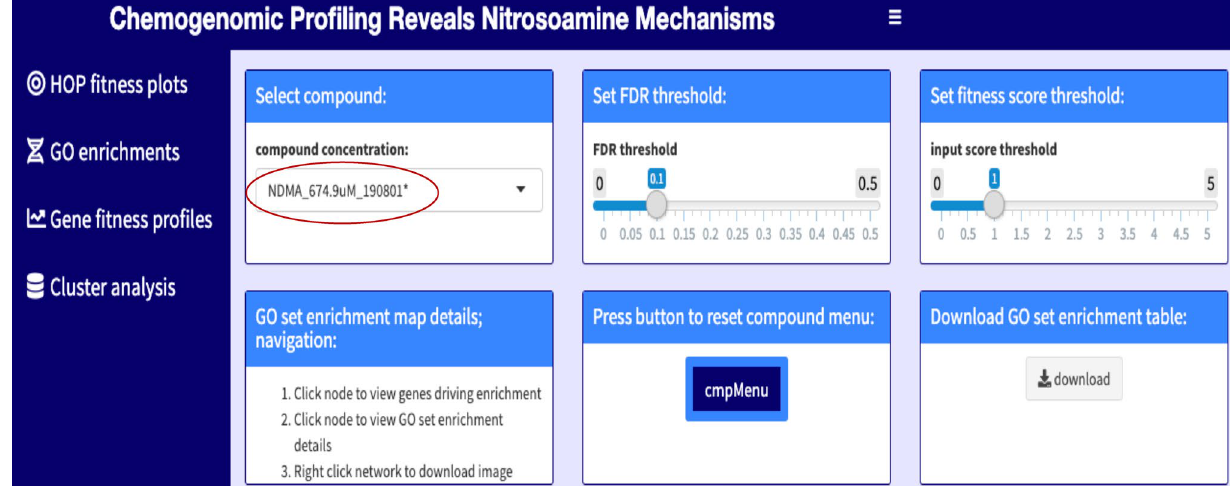
Figure 1. Layout of the interactive chemogenomic web application. Selecting a compound of interest from the drop-down list (red circle), will allow one to explore (left panel) its fitness profile, GO enrichment profile, individual gene fitness profile (cofitness) or cluster analysis of all the compounds in our screens. Compounds were saved with their final concentration and the date (yy/mm/dd) when the count matrices were performed e.g. NDMA_674.9µM_190801. To allow for custom visualizations, the user can adjust thresholds for FDR and fitness scores. Image is a screenshot from the web caused growth defect of the PRO1 mutant, this gene encodes gamma-glutamyl kinase, an enzyme of the proline biosynthetic pathway. NDEA caused fitness defects on mutants lacking genes of the tryptophan biosynthesis ( TRP1 , TRP3 , TRP4 and TRP5 ) and cysteine biosynthesis ( CYS3 and CYS4 ). Deletion strains of the arginine biosynthetic pathway genes are hypersensitive to DMF. Dur- ing the investigation into the source of N-nitrosamine contamination, several lines of evidence pointed to a manufacturing switch to the solvent DMF 2,3 for the production of the APIs (Fig. 4) as a culprit. We therefore performed genome-wide screens on DMF as described for the three N-nitrosamines and found growth was impaired in strains deleted for the arginine metabolic genes ARG1 , ARG2 , ARG3 , ARG4 , ARG5,6 , ARG7 , CPA1 , CPA2 and ORT1 (Fig. 2D). The GCN4 deletion strain, as noted above, also had reduced fitness in DMF. Mutants deleted for genes involved in ATP export (e.g. SNF7 , SNF8 , STP22 , VPS28 , VPS20 , VPS25 , DID4 ) and vacu- olar protein sorting (e.g. SNF8, VPS25, VPS8, VPS27 ) showed reduced growth in DMF. Other affected mutants include those lacking genes of the fatty acid biosynthesis ( CEM1 , ELO3 , HTD2 , MCT1 and PPT2 ), protein lipoylation ( AIM22 , GCV3 , LIP2 and LIP5 ), and biotin biosynthesis pathways and iron–sulfur cluster assembly ( ISA1 , ISA2 and IBA57 ). Overall, 58 deletion strains showed growth defects on exposure to DMF, and 27 of these